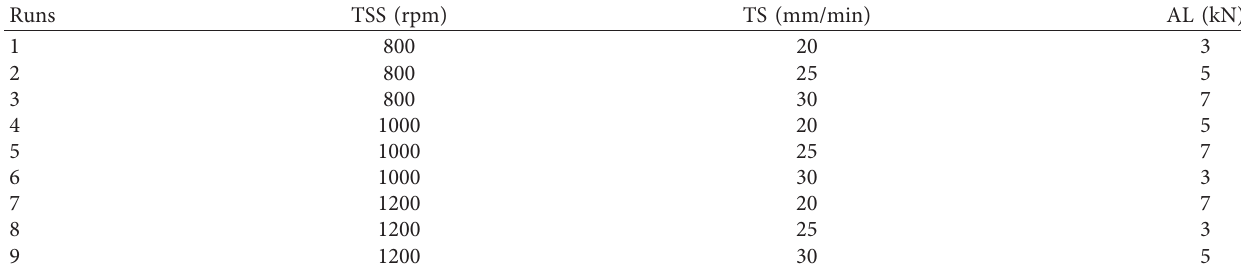
Table 3: Design of the experimentation by using the L9 orthogonal